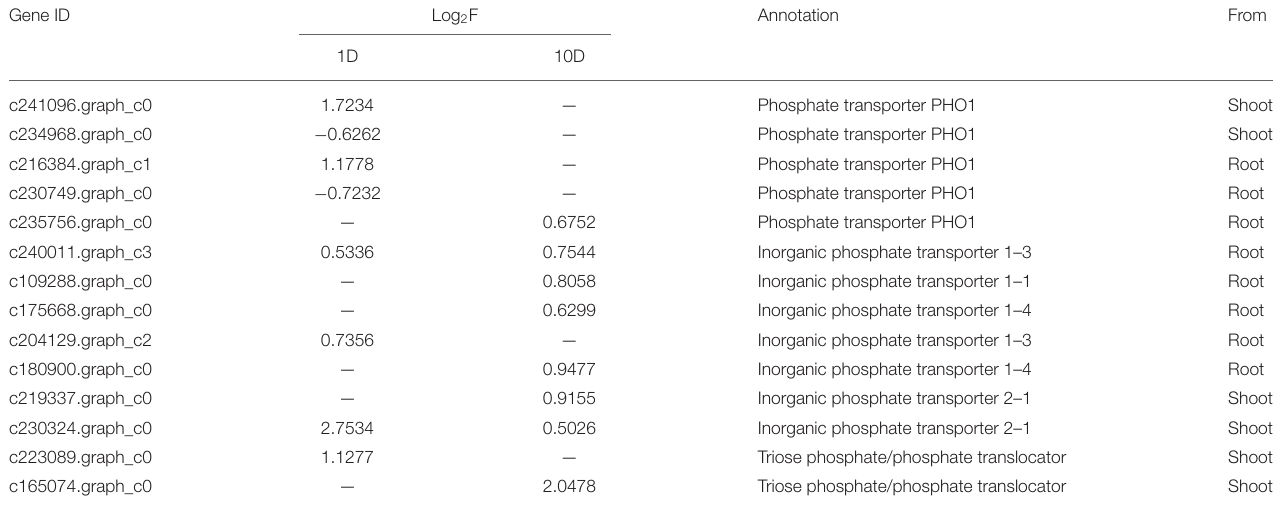
TABLE 5 | DEGs of phosphate transporters.